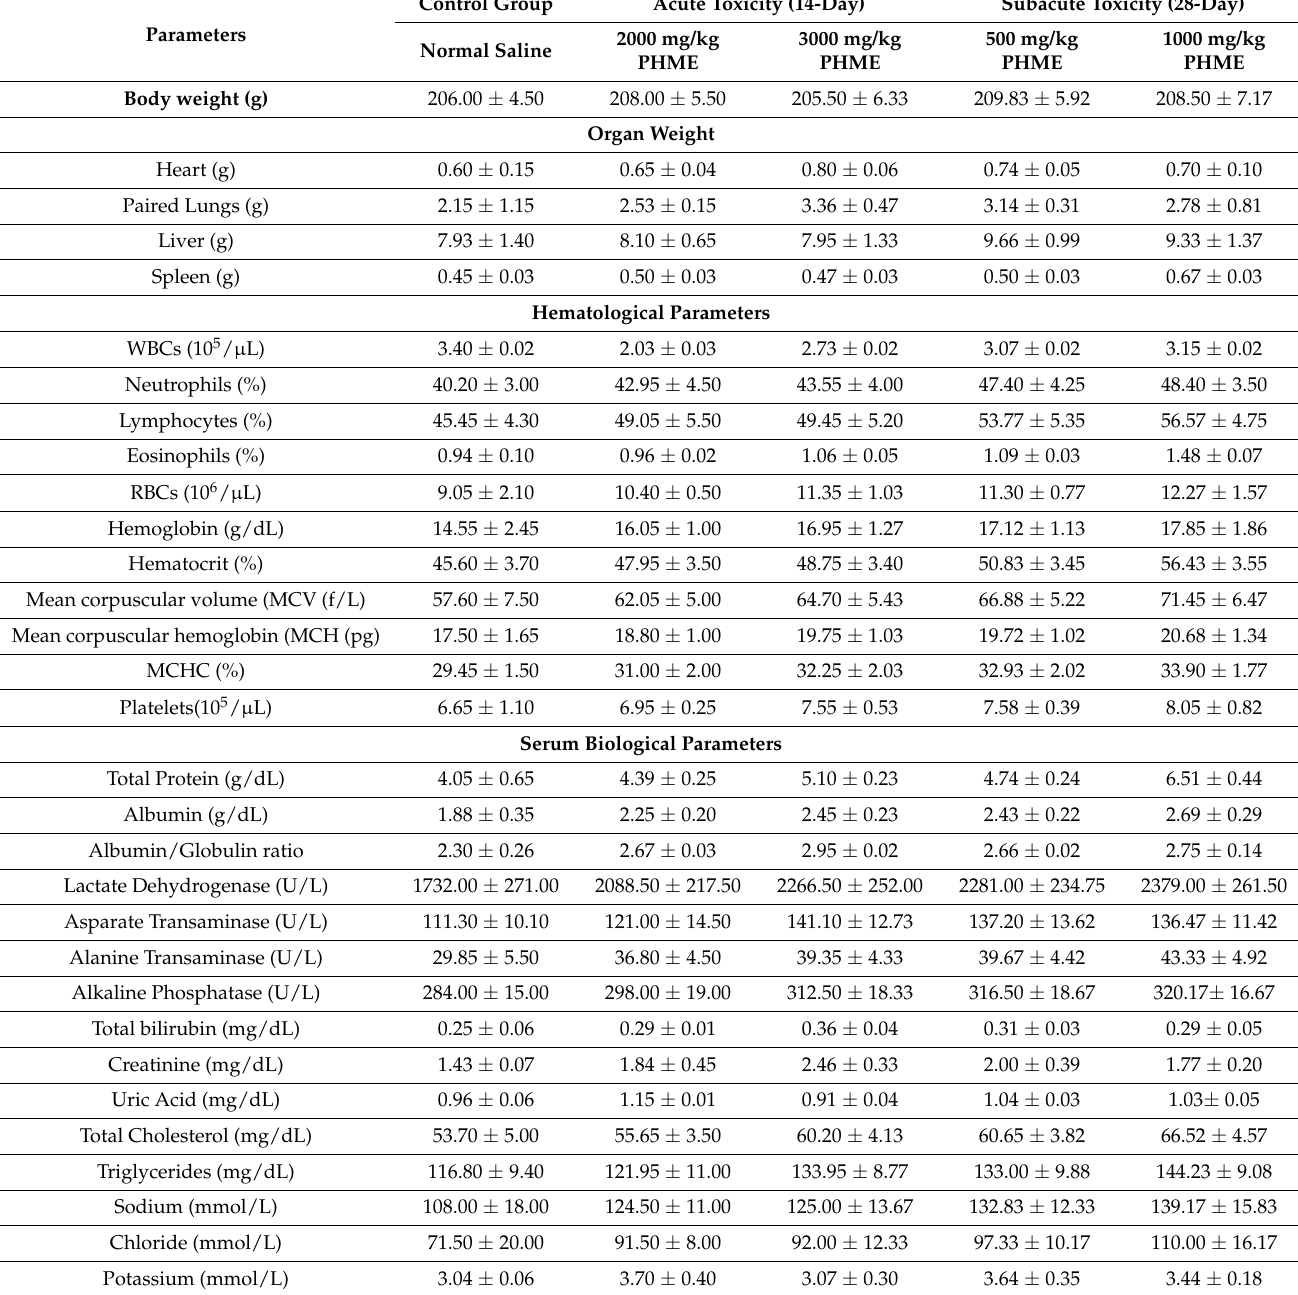
Table 3. Acute and subacute toxicity assessment of Peganum harmala methanol